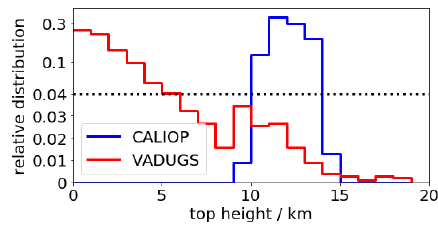
Figure 11. CALIOP and VADUGS retrievals of VATH; the vertical line separates the linear lower part from the logarithmic upper